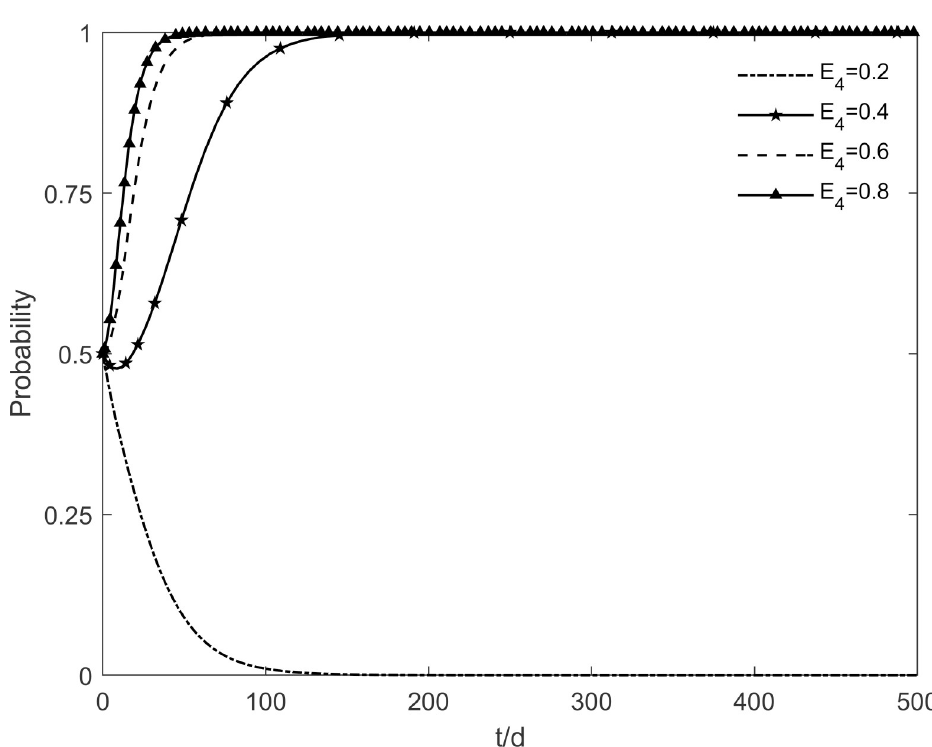
Fig 22. The impact of E 4 on the investment retrofitting enterprises’ strategic choices.